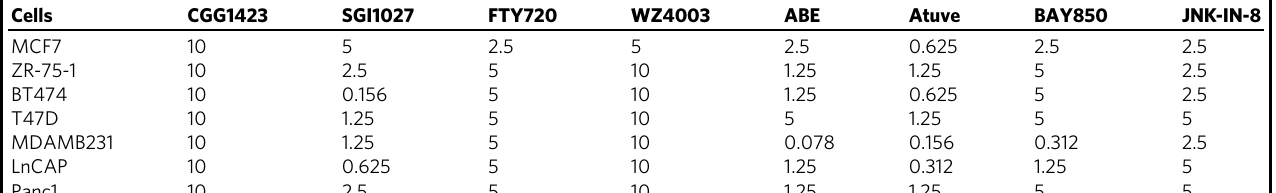
Table 1 Summary of substances concentrations in µ M for Figs. 3d, 5, and 6. Cells